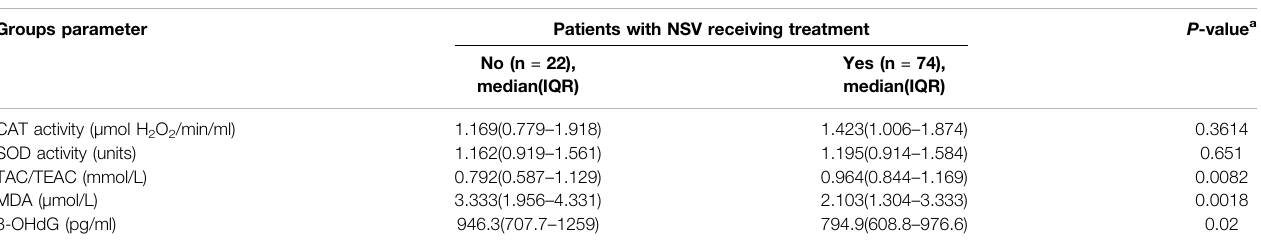
TABLE 4 | Serum levels of OS markers in NSV patients receiving or without therapy in the past 1 year. Groups